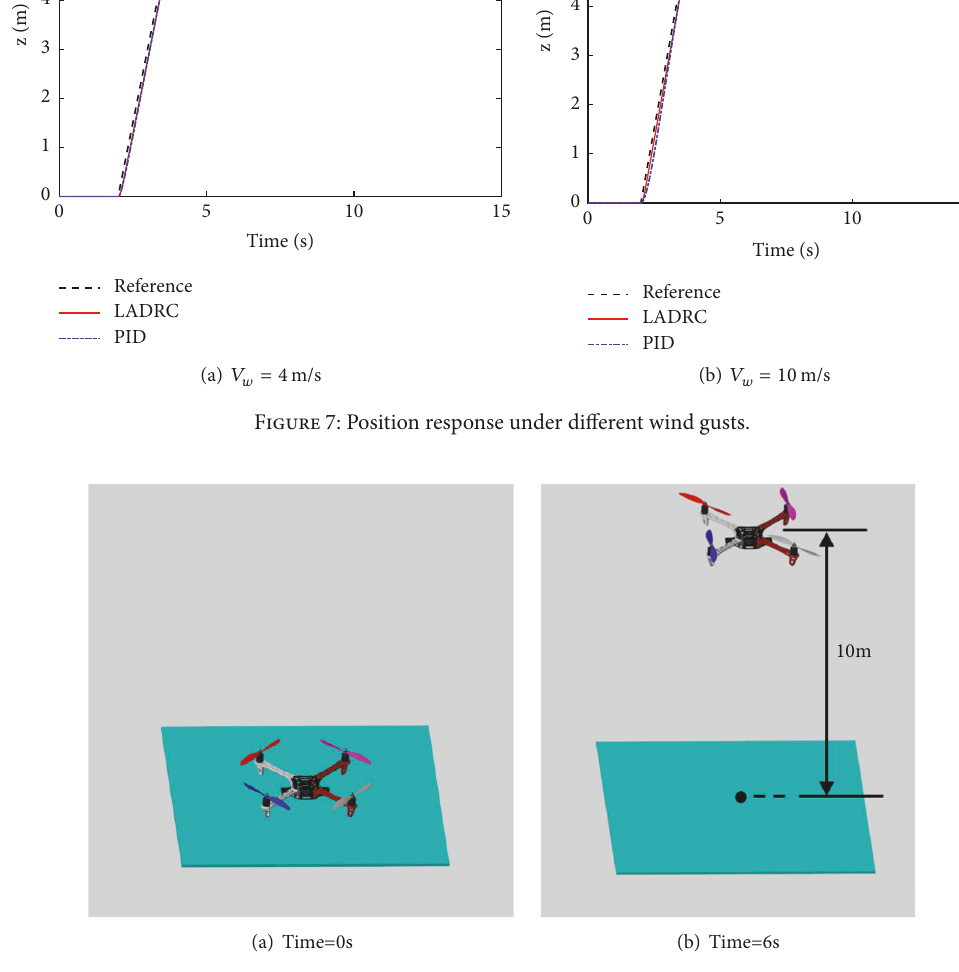
Figure 8: Hovering control in Simscape